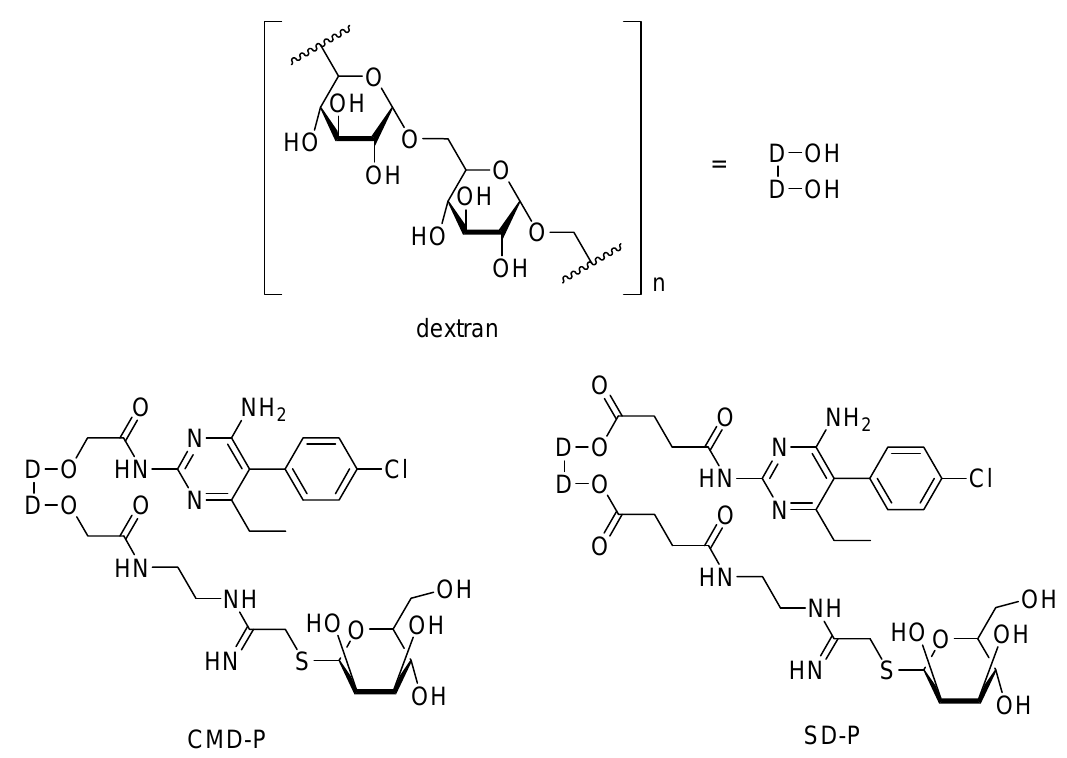
Figure 10. Chemical structure of the prodrugs CMD-P and